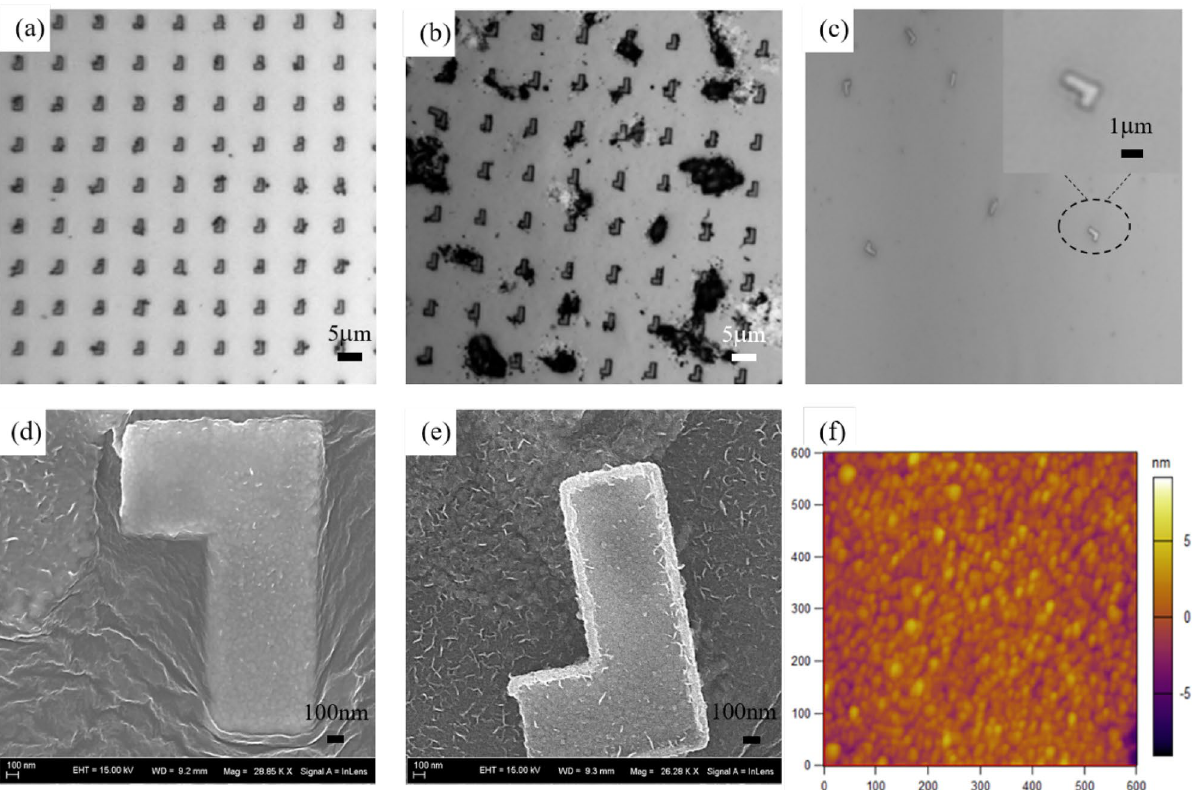
Figure 2. Characterization of the nanorobots. ( a ) microscope image of nanorobots before release. Nanorobots submerged in NaOH and H 2 O 2 for ( b ) 10 min and ( c ) 20 min. SEM images of the ( d ) top and ( e ) bottom surfaces of the nanorobot. ( f ) AFM image of the granular Ti surface of a nanorobot; the granular surface can promote cell adhesion.